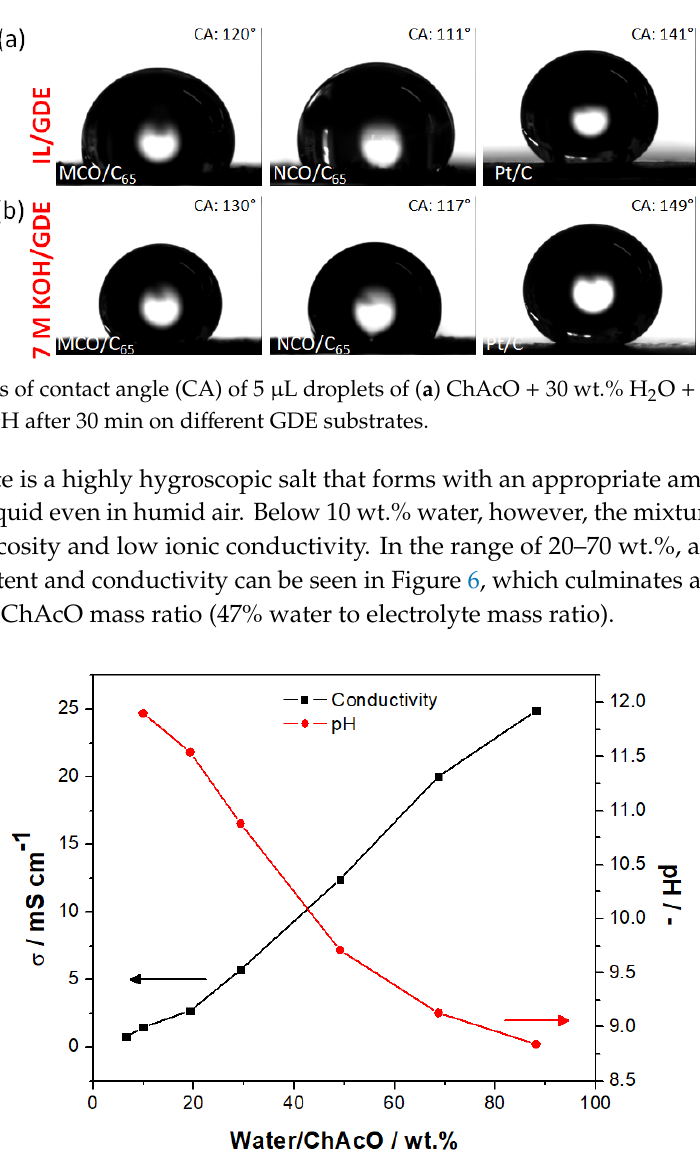
Figure 6. Ionic conductivity and pH values in dependency of water / ChAcO mass ratio at 20 ◦ C. The corresponding conductivity and pH as well as density values are listed in Table S1.